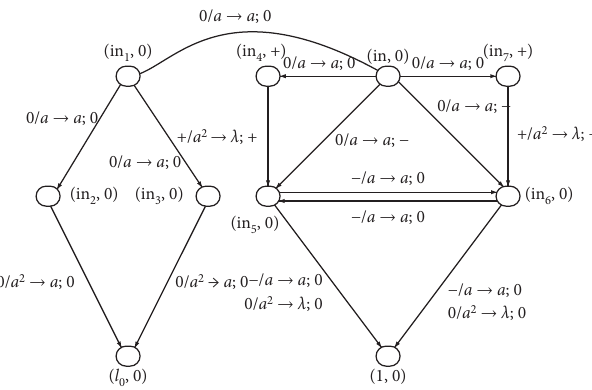
Figure 4: INPUT module of Π